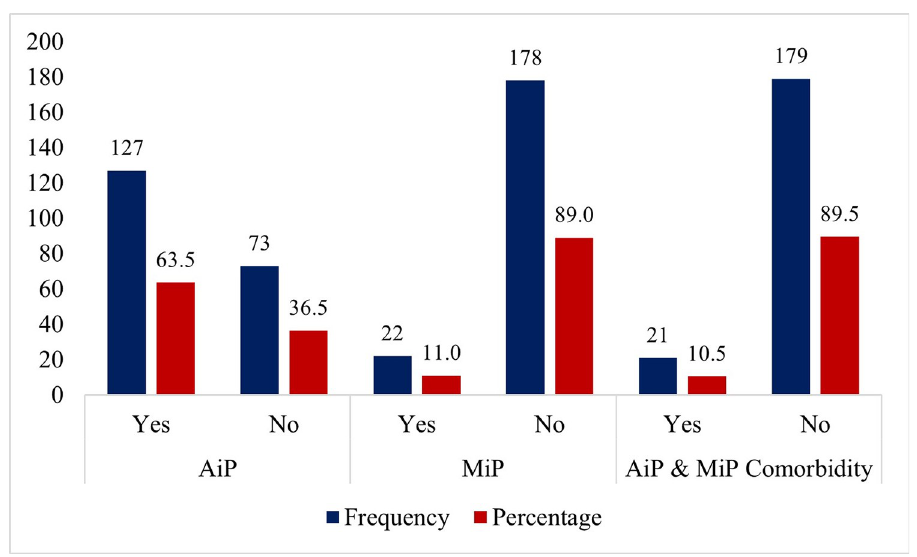
Fig 2. Distribution of malaria, anaemia and malaria/anaemia comorbidity stratified by maternal